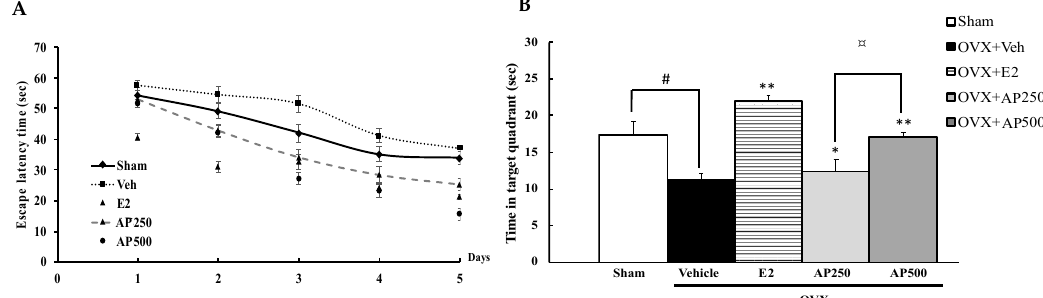
Figure 1. Latency time of training the mice to find the target platform (n = 8–10). Values given were the mean ± SEM of latency, 4 trials/day for 5 days ( A ). The effect of the AP extract on OVX-induced cognitive impairment in the MWMT ( B ). Time in the quadrant where the platform was located was observed on the sixth day. Each column represents the mean ± SEM (n = 8–10). # p < 0.05 vs. the sham-operated group, * p < 0.05, ** p < 0.001 vs. the OVX group and ¤ p < 0.001 vs. the AP extract (post hoc Tukey